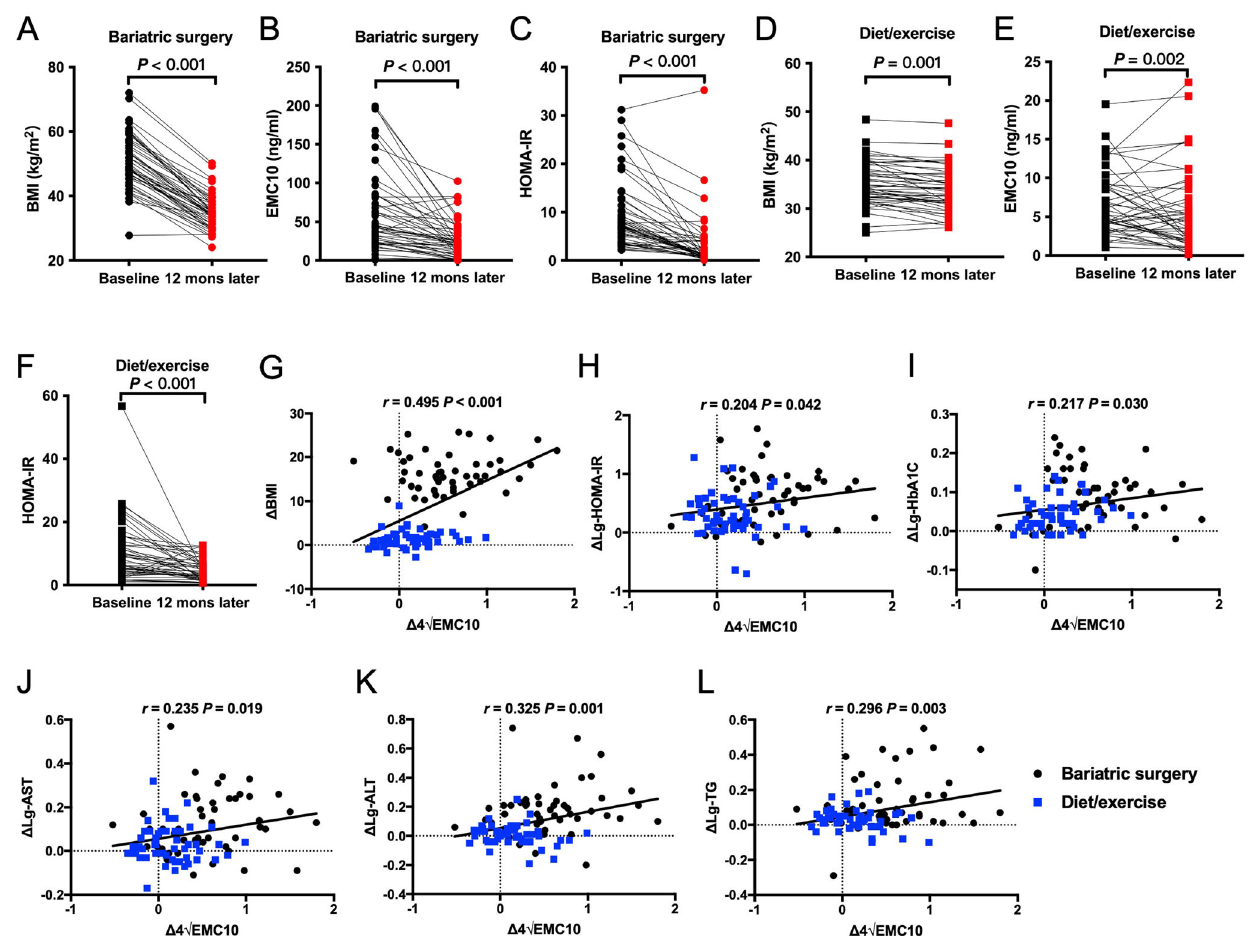
Fig.2|SerumEMC10levelsinwhiteweight-losscohorts.A – C BMI,serumEMC10 concentration, or HOMA-IR of white human study participants before and 12 months after bariatric surgery, respectively ( n =50), *** p <0.001. D – F BMI, serum EMC10 concentration, or HOMA-IR of white human study participants before and 12 months after diet/exercise weight-loss intervention, respectively ( n =50). Comparisons between before and after were performed using Student ’ s